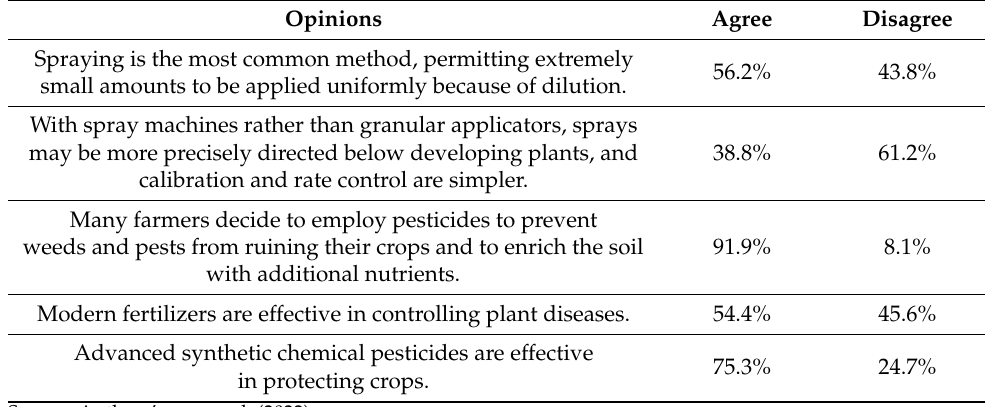
Table 5. Opinions on the relationship between chemical techniques with regard to crop protection. Opinions Agree